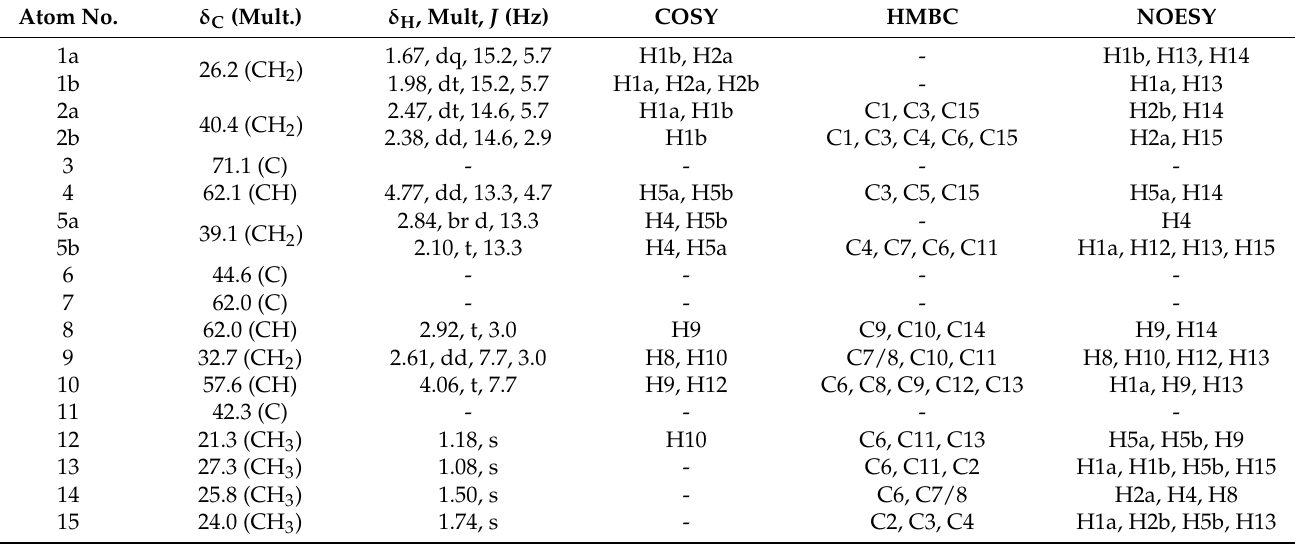
Table 5. NMR spectroscopic data for compound 1